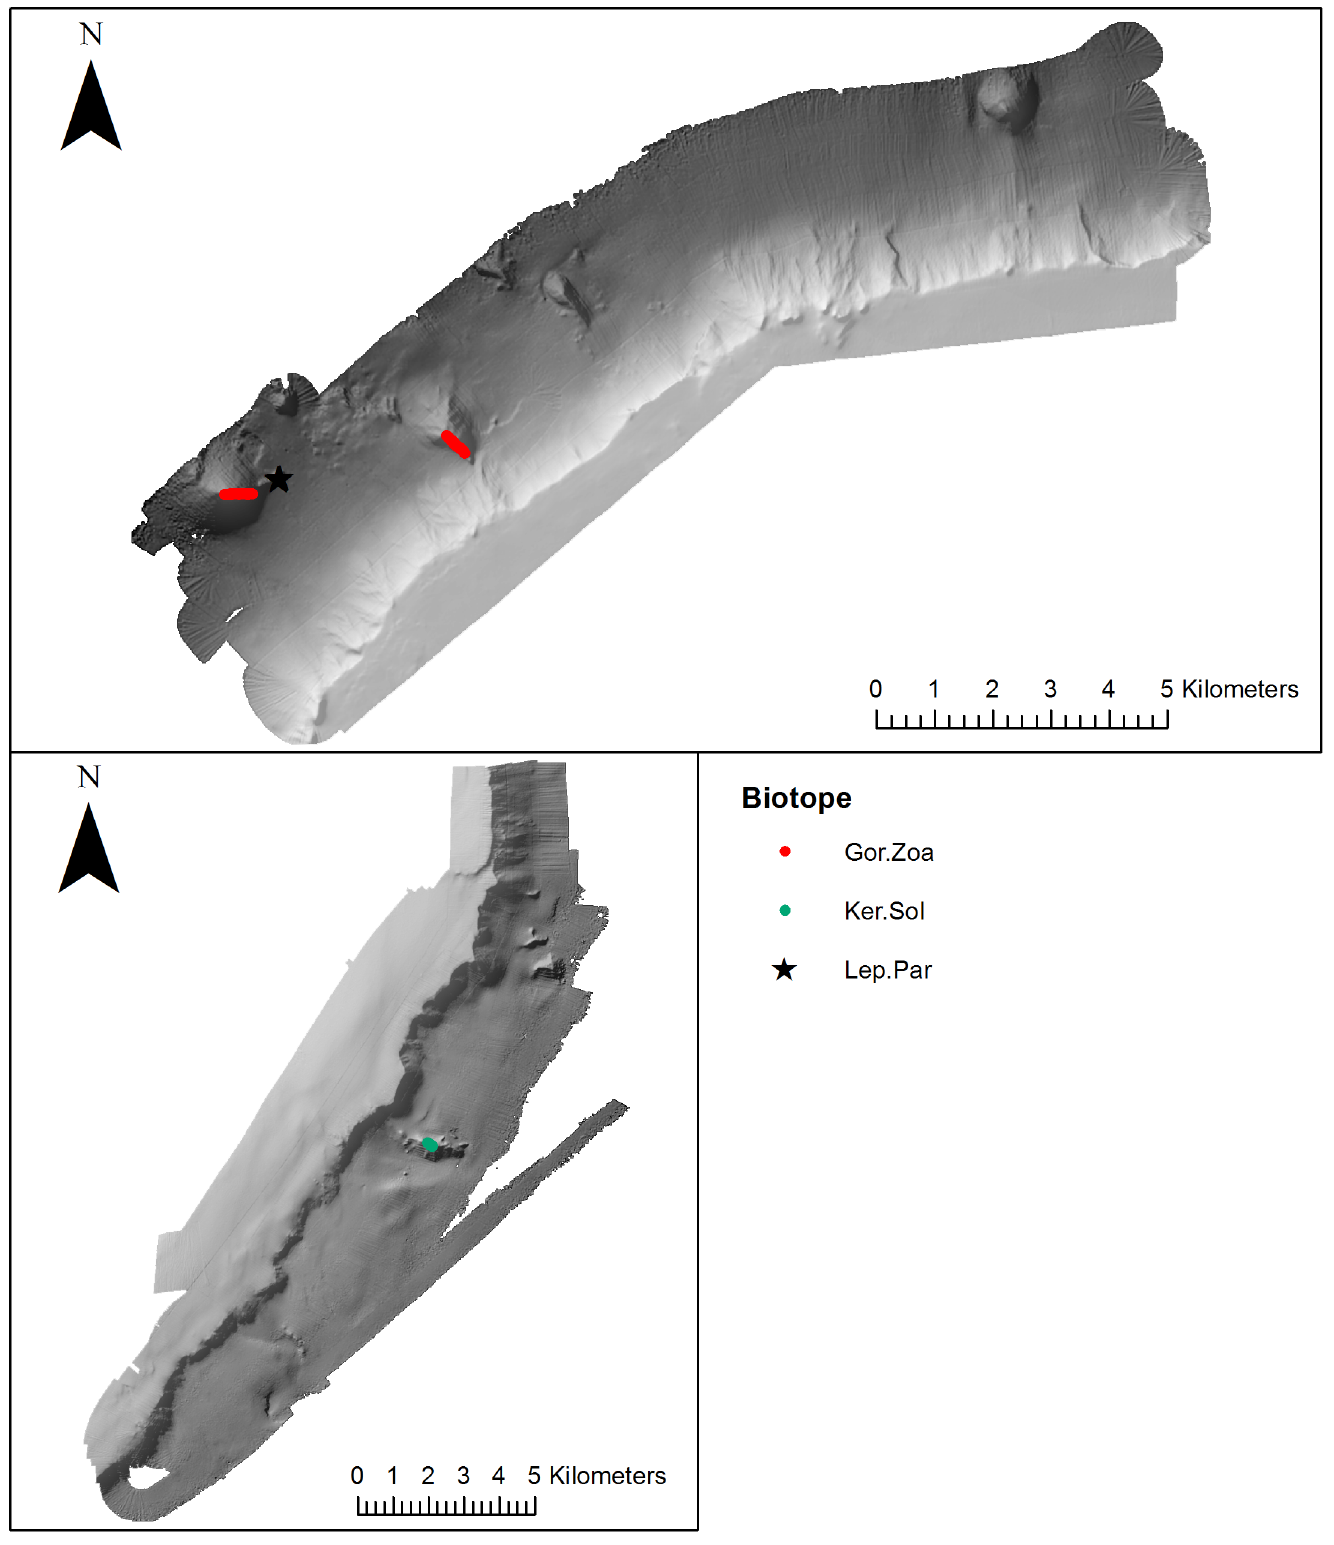
Fig 6. Distribution of coral garden biotopes (mapped using video footage) on the NW and SE side of Anton Dohrn Seamount. Refer to Fig 2 for bathymetric scale.